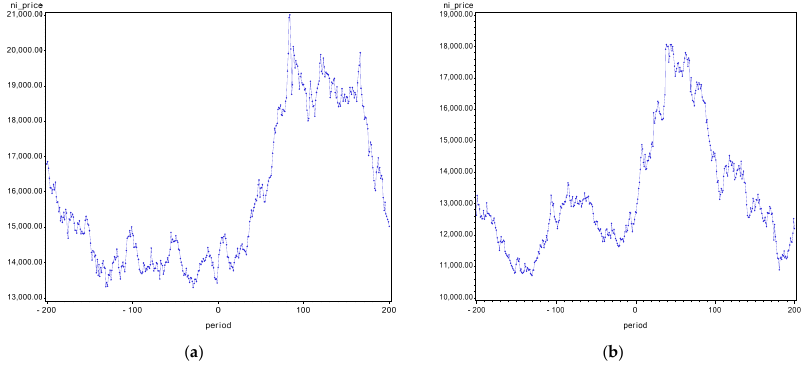
Figure 1. LME nickel prices. The period 0 means the day of the focal episode, i.e., the announcement day. ( a ) The first focal episode on 10 January 2014; ( b ) the second focal episode on 8 July 2019. Figures imply that such a big shift in Indo- nesian government action in response to LME nickel prices represents a significant shock.